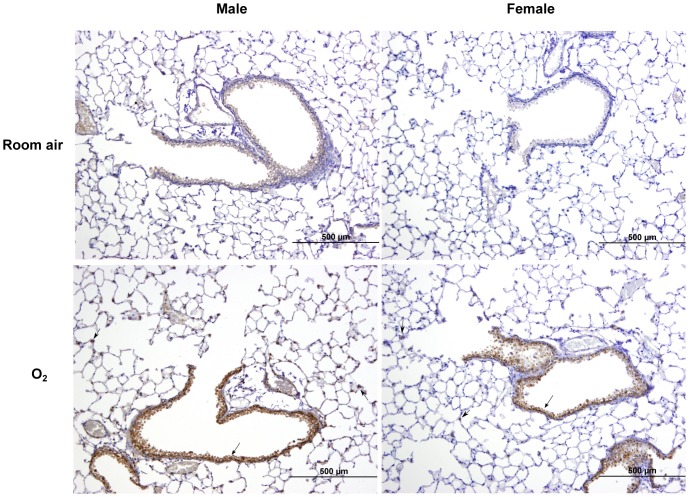
Increased Slc7a11 expression in the lungs (male or female) following hyperoxia exposure.Representative sample of immunohistochemical staining for Slc7a11 in the lungs of male or female mice at room air and after exposure to hyperoxia for 48 h (n = 5 animals/group).